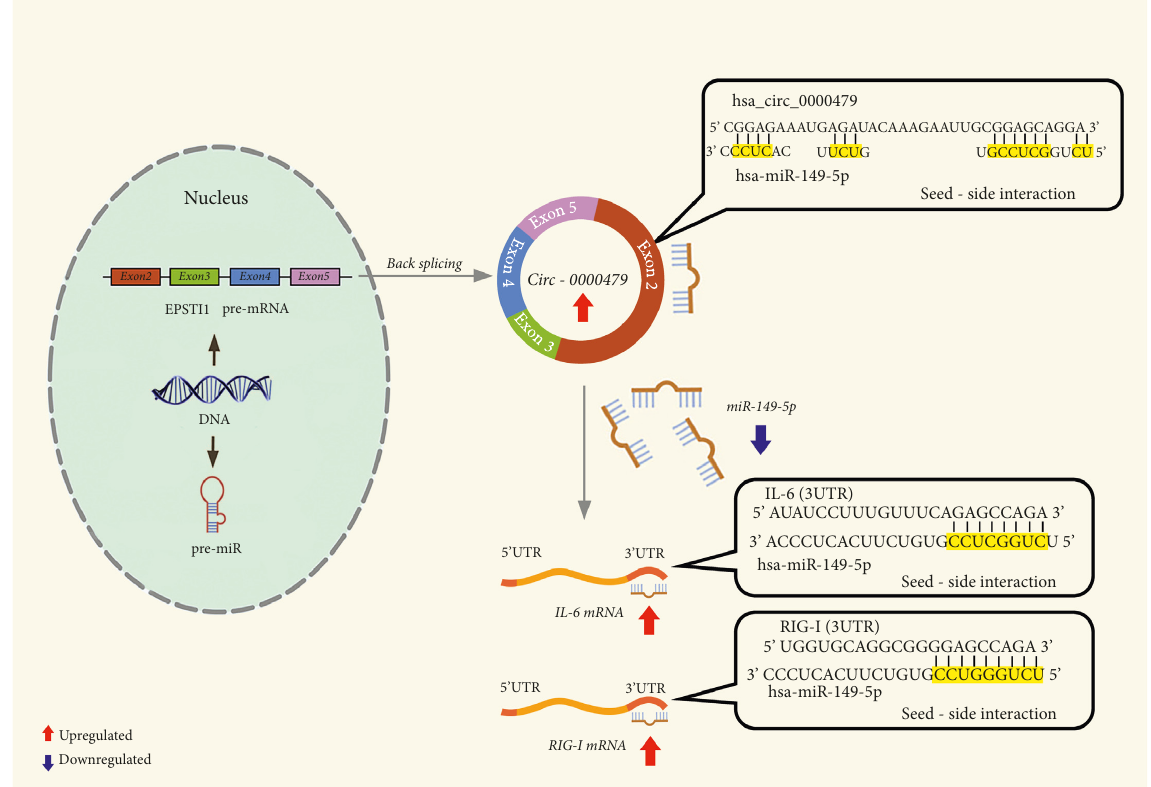
Figure 3: The schematic diagram demonstrates that hsa_circ_0000479 could modulate the expression of IL-6 and RIG-I through sponging of hsa-miR-149-5p in SARS-CoV-2 infection.